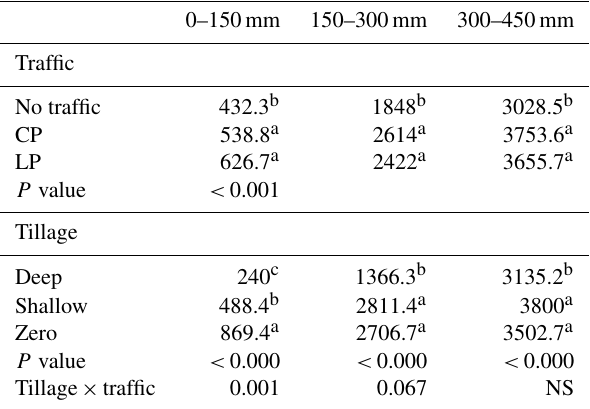
∗ A significant difference between means is represented by different